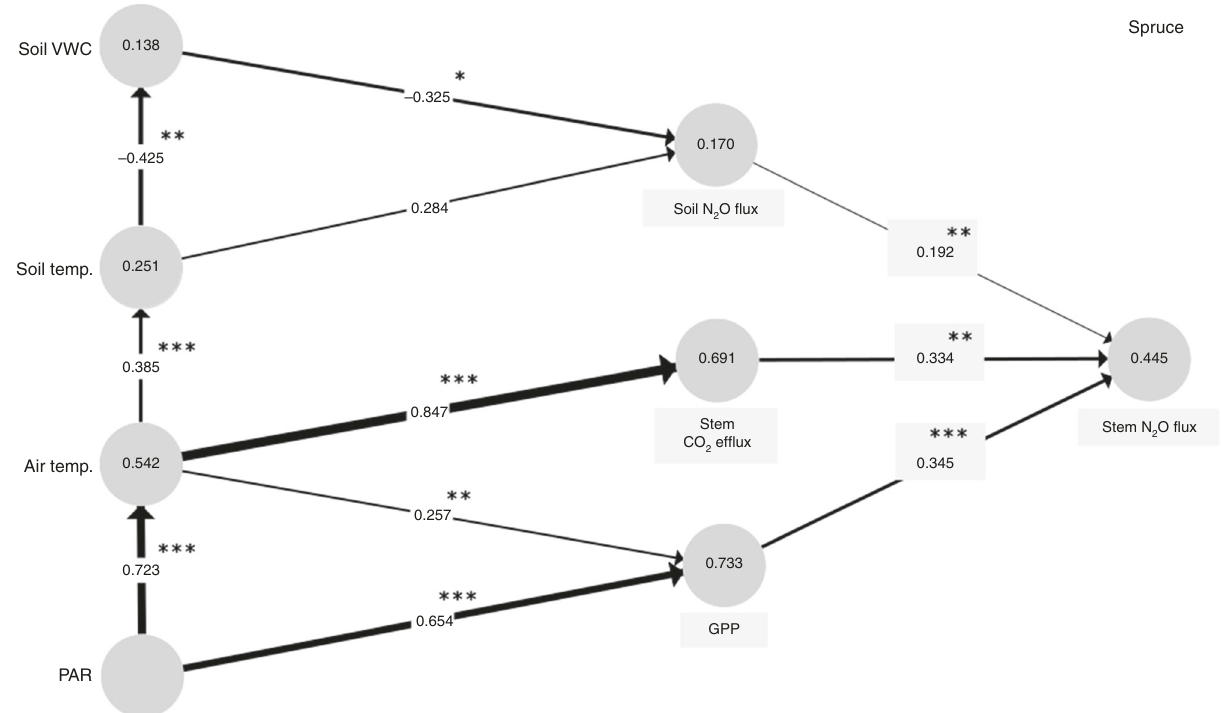
Fig. 4 Prediction of N 2 O fl uxes in spruce stem. Path diagram, created on the base of partial least squares path modelling, describes relationships among stem N 2 O fl uxes and most predictive environmental, physiological, and ecosystem variables (drivers of N 2 O fl uxes) for 2014 – 2015. Values in circles report coef fi cients of determination ( R 2 ). Values included in arrows mark the path coef fi cients, whose signi fi cance levels are expressed as follows: * p < 0.05, ** p < 0.01, *** p < 0.001. Soil volumetric water content (Soil VWC), photosynthetically active radiation (PAR), gross primary production (GPP). Soil N 2 O fl ux expresses forest fl oor N 2 O fl